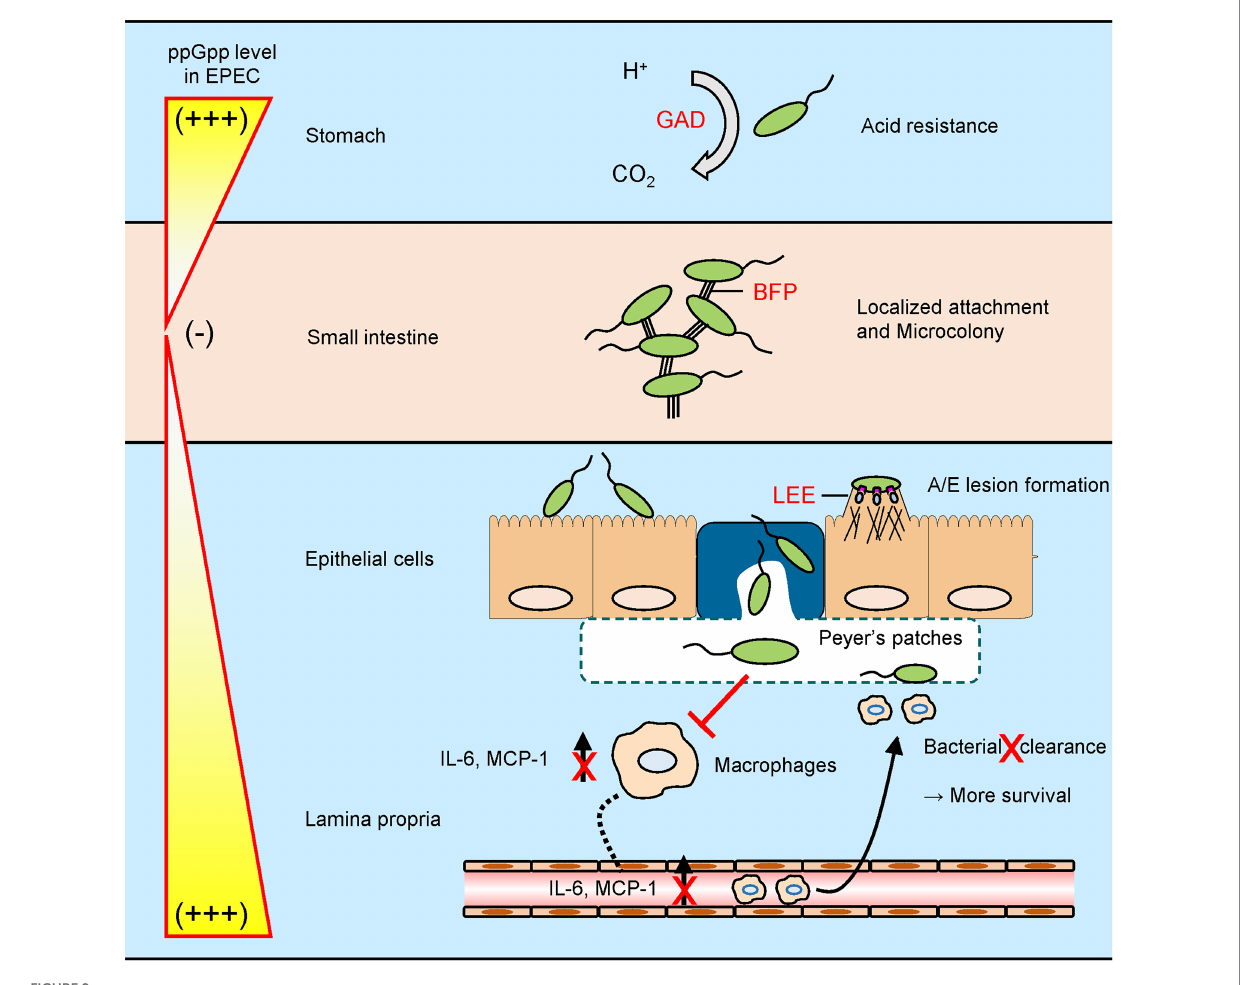
FIGURE 9 A schematic model for stringent control by EPEC during a host gastrointestinal tract infection. EPEC exhibits its virulence by controlling intracellular guanosine tetraphosphate (ppGpp) levels in response to host environments. (i) To survive in an acidic stomach, EPEC synthesizes ppGpp to induce glutamate decarboxylase-dependent acid resistance. (ii) After entering a nutrient-rich small intestine, EPEC degrades ppGpp to facilitate microcolony formation by type IV bundle forming pilus. (iii) Nutrient limitation caused by dense cell population in microcolony promotes ppGpp synthesis and dispersal of EPEC cell aggregates. Subsequently, ppGpp-mediated locus of enterocyte effacement expression allows EPEC cells to adhere onto intestinal epithelium intimately, creating attaching and effacing lesions. (iv) When exposed to macrophages in Peyer’s patches, EPEC deploys its ppGpp signaling to block both cytokine induction and subsequent bacterial